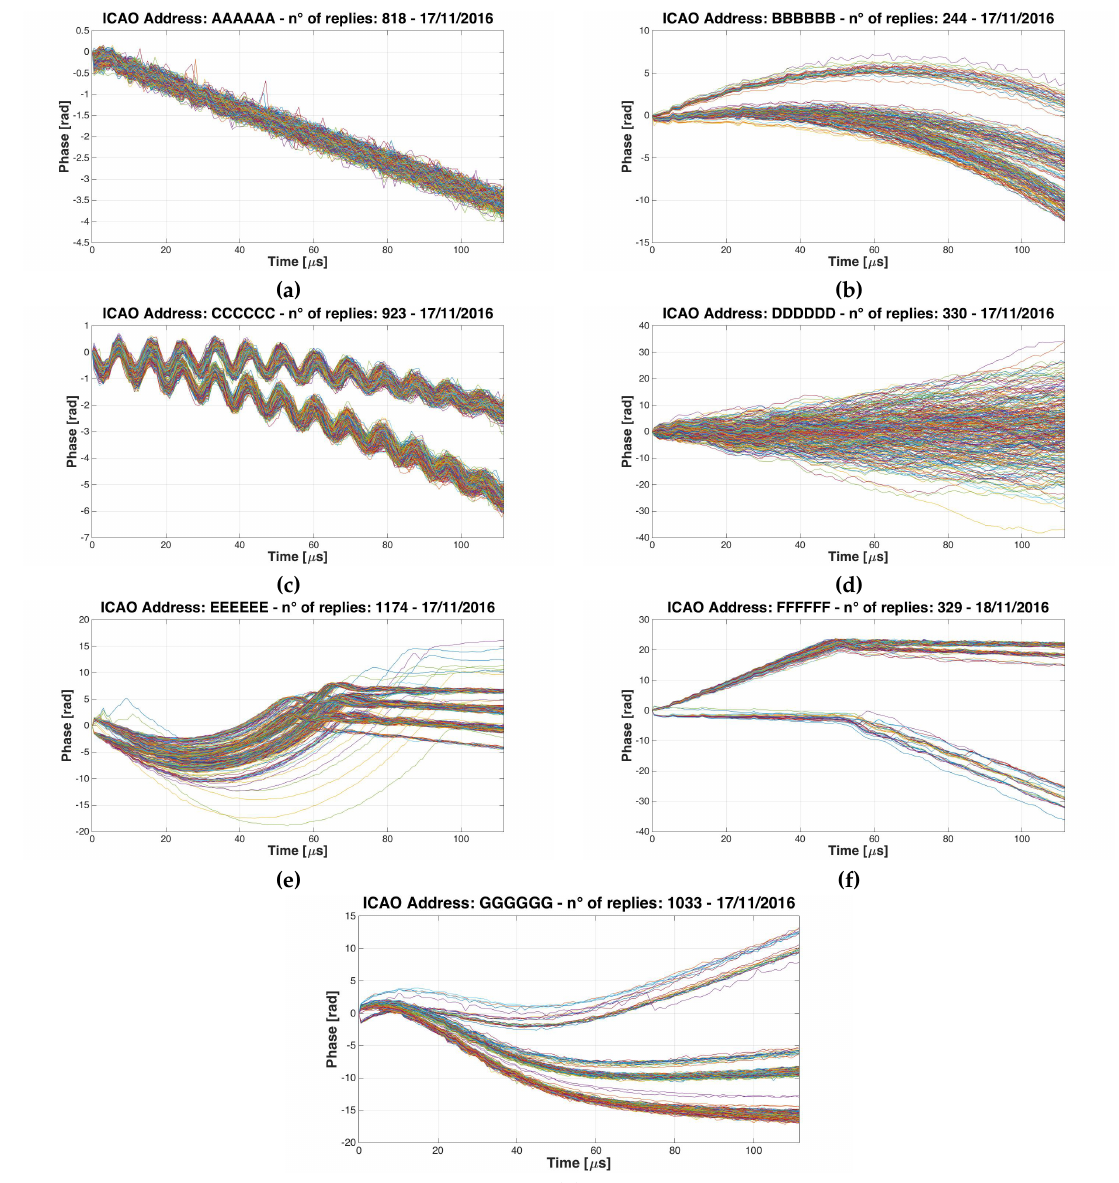
Figure 5. Phase patterns examples of seven different aircraft: ( a ) Linear; ( b ) Quadratic; ( c ) Oscillating; ( d ) Non-Coherent; ( e ) Mixed: Quadratic+Linear; ( f ) Mixed: Linear + Linear and ( g ) Wave. All ICAO Addresses are